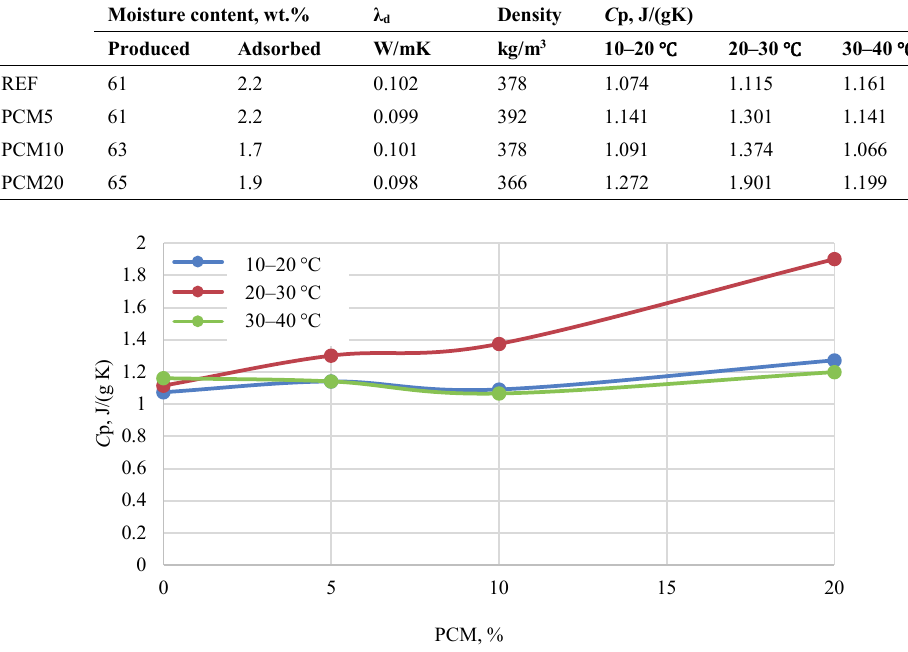
Fig. 5. Average specific heat capacity of gypsum hempcrete with PCM at different temperature